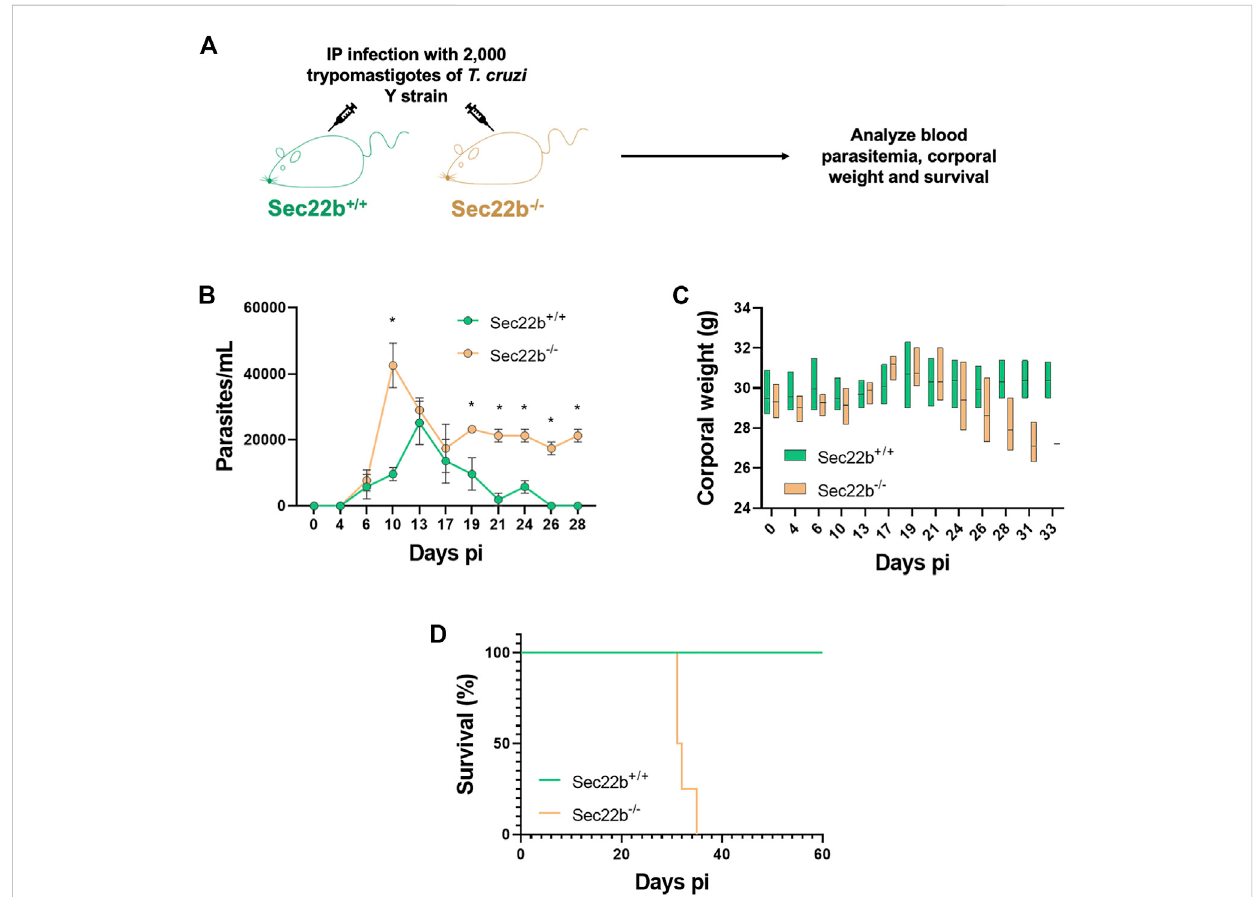
FIGURE 4 Parasitemia,corporalweightandsurvivalofinfectedmice. (A) Experimentalscheme.Sec22b − / − andSec22b +/+ malemice(N=4eachgroup)wereIP infected with 2,000 T. cruzi Y strain trypomastigotes. Blood parasitemia, corporal weight and survival were analyzed over time (up to day 60 pi). (B) Parasitemia,expressedasparasitespermL(andrepresentedasmeanwithSEM),wasdeterminedintailblood,asthenumberofparasitesperml.Statistical comparison was performed per day using the Mann-Whitney test, all p-values < 0.05 at days 10, 19, 21, 24, 26 and 28 dpi (days post infection). (C) Corporalweight(g)measuredatseveraldayspostinfectionandrepresentedasboxplotwithlineatmean. (D) SurvivalcurvesforSec22b − / − andSec22b +/+ mice. Statistical analysis was performed with Log-rank (Mantel-Cox) test, p-value :